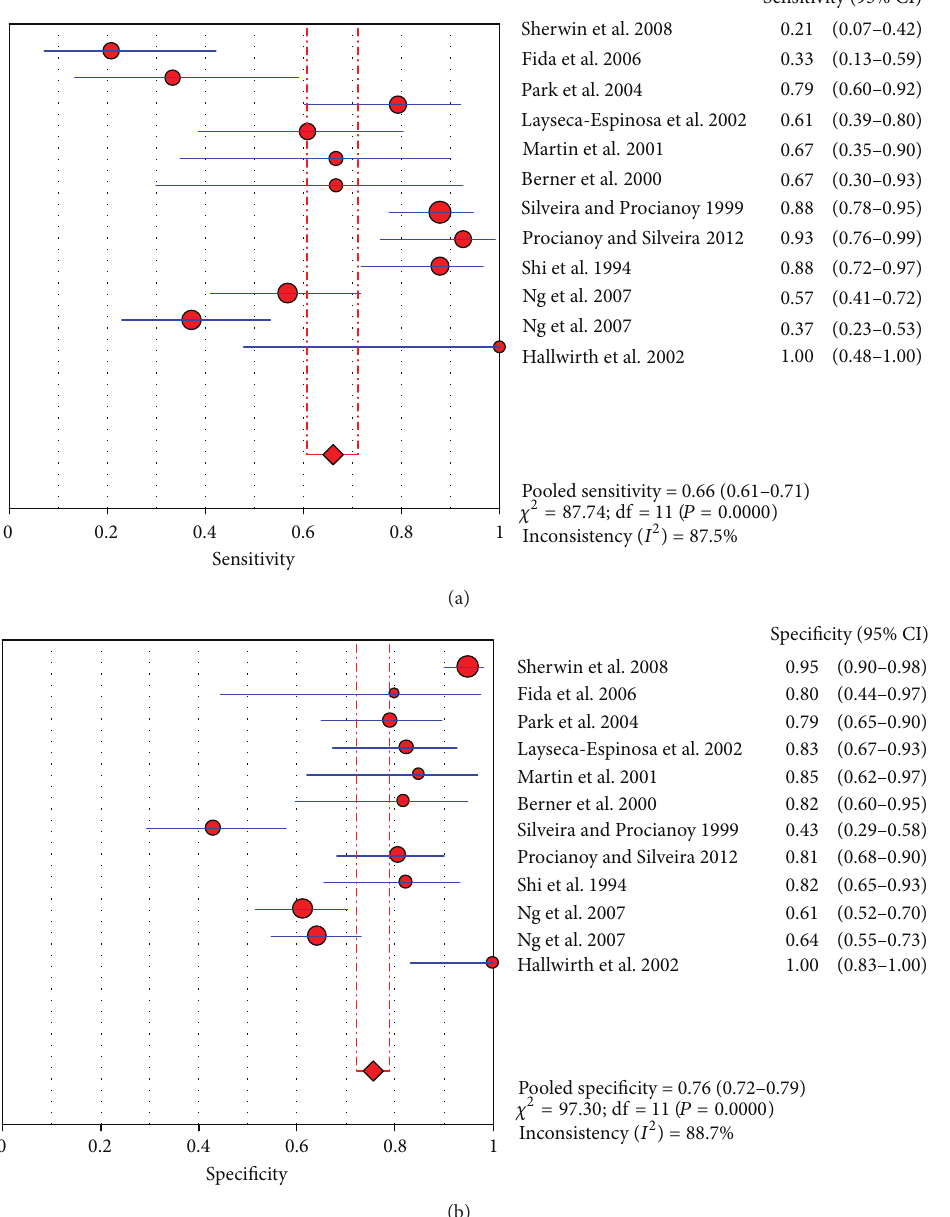
Figure 2: Forest plot for sensitivity and specificity of the TNF- 𝛼 test to diagnose neonatal sepsis at the